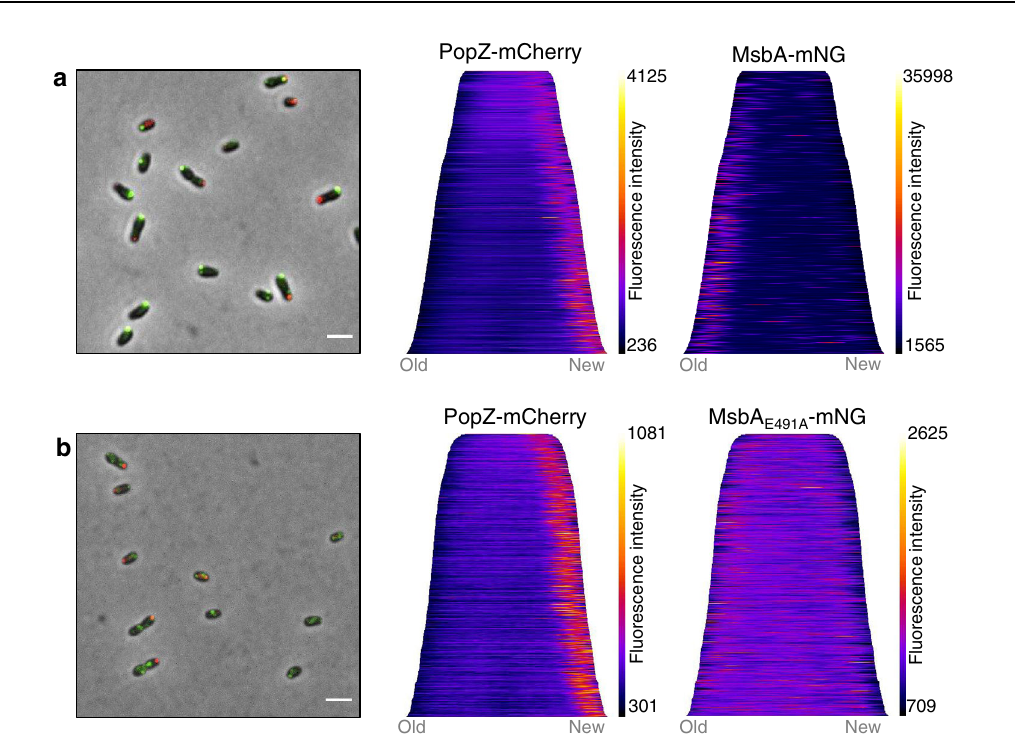
Fig. 4 | LptC and LptF localization in A. tumefaciens . Both mNG-LptC and mNG- LptF are localized at the new pole and the constriction site in A. tumefaciens . Bac- teria were labelled with HADA to highlight the new pole in Rhizobiales. The